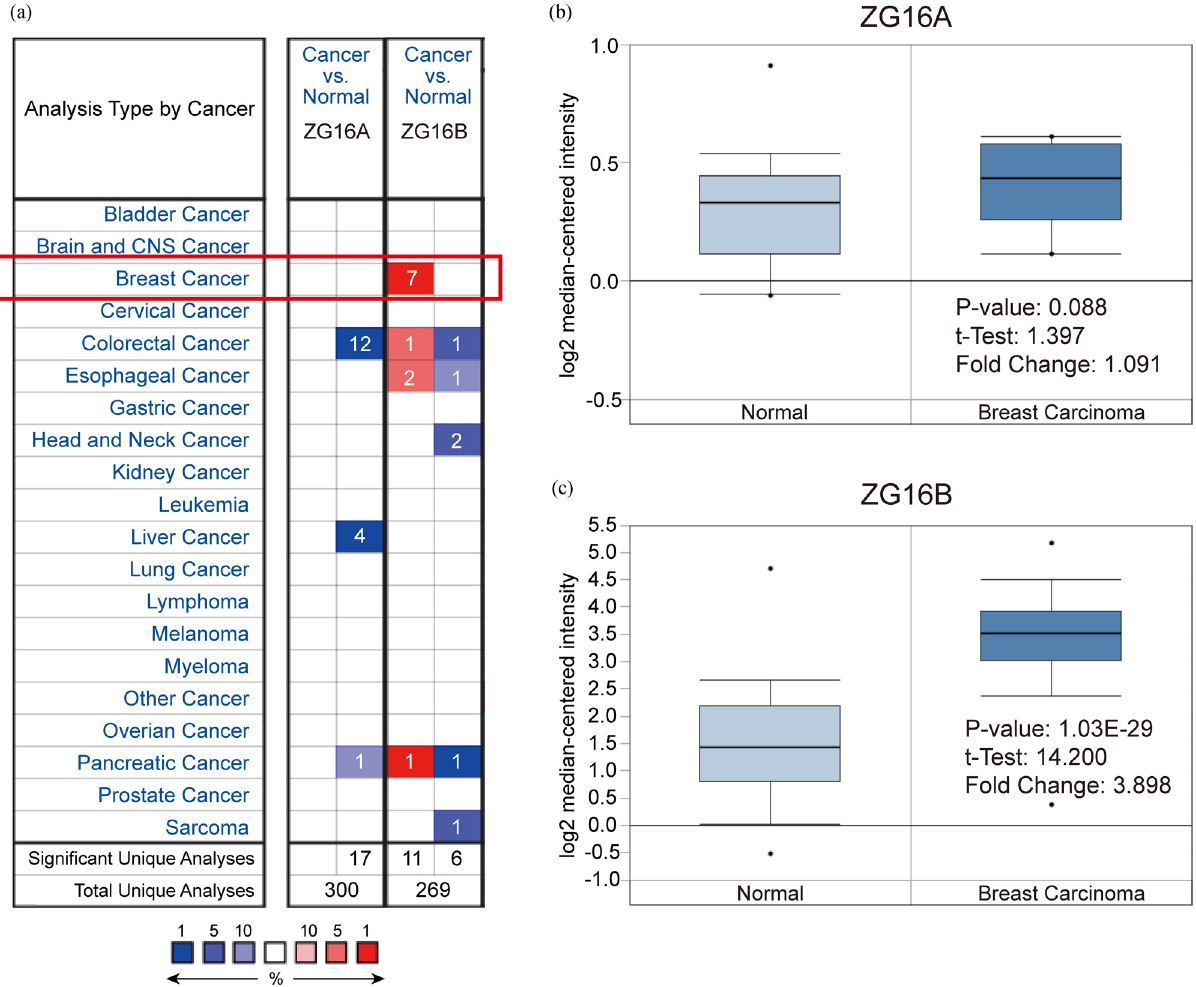
Figure 1: Analysis of ZG16A and ZG16B mRNA expression in di ff erent types of cancer ( Oncomine ) . ( a ) The mRNA expression pattern of ZG16A and ZG16B in various cancers. The number in the grid represented the number of datasets that meet the fi xed threshold ( p < 1 × 10 − 4 , fold change > 2 ) . The color of the grid represented if the gene expressed higher ( red ) or lower ( blue ) ( cancer vs. normal ) . The color depth of the grid depended on the best gene rank percentiles in all genes detected in each analysis. Box plots derived from gene expression data in Oncomine comparing the mRNA expression of ZG16A ( b ) and ZG16B ( c ) in normal and breast cancer